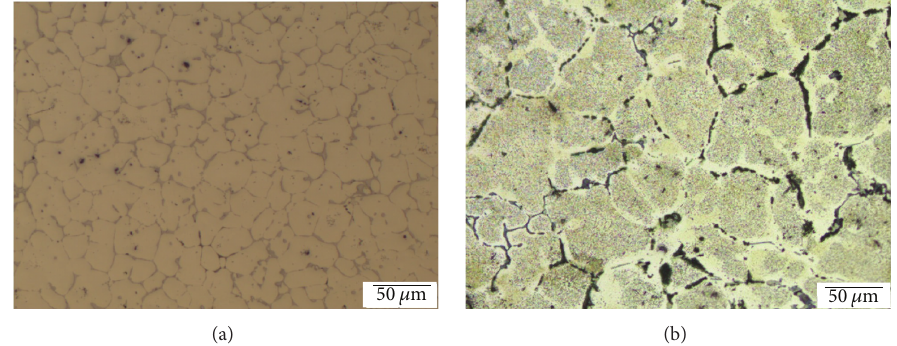
Figure 5: Microstructure of Al4.8 wt%Cu. (a) As cast. (b) after soaking for 24 h at 525 ∘ C. Samples were etched with 0.5% HCl solution during 5 min.